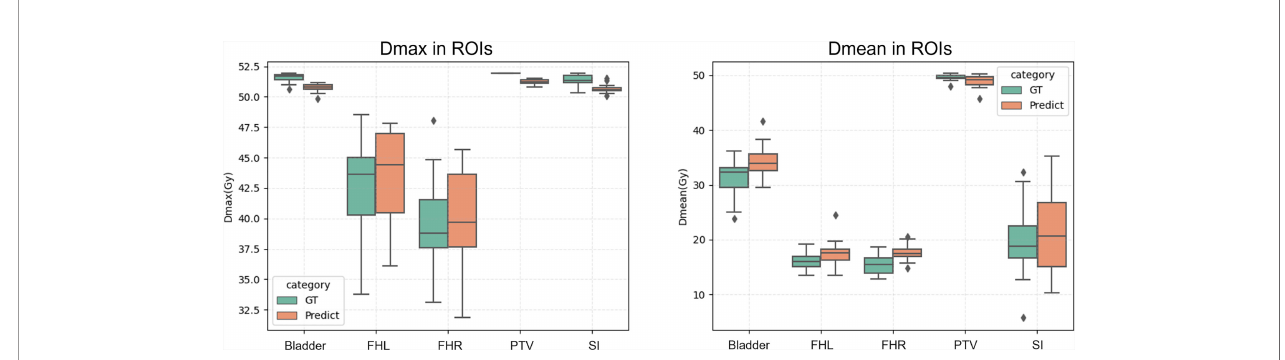
FIGURE 5 | Dmax (left) and Dmean (right) of the proposed prediction and the ground truth with respect to ROIs. Horizontal lines in boxes are medians and rhombuses are outliers.